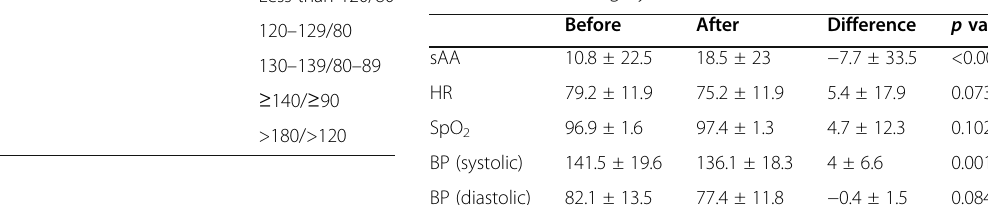
Table 3 Paired comparison between the different parameters before and after surgery Before After